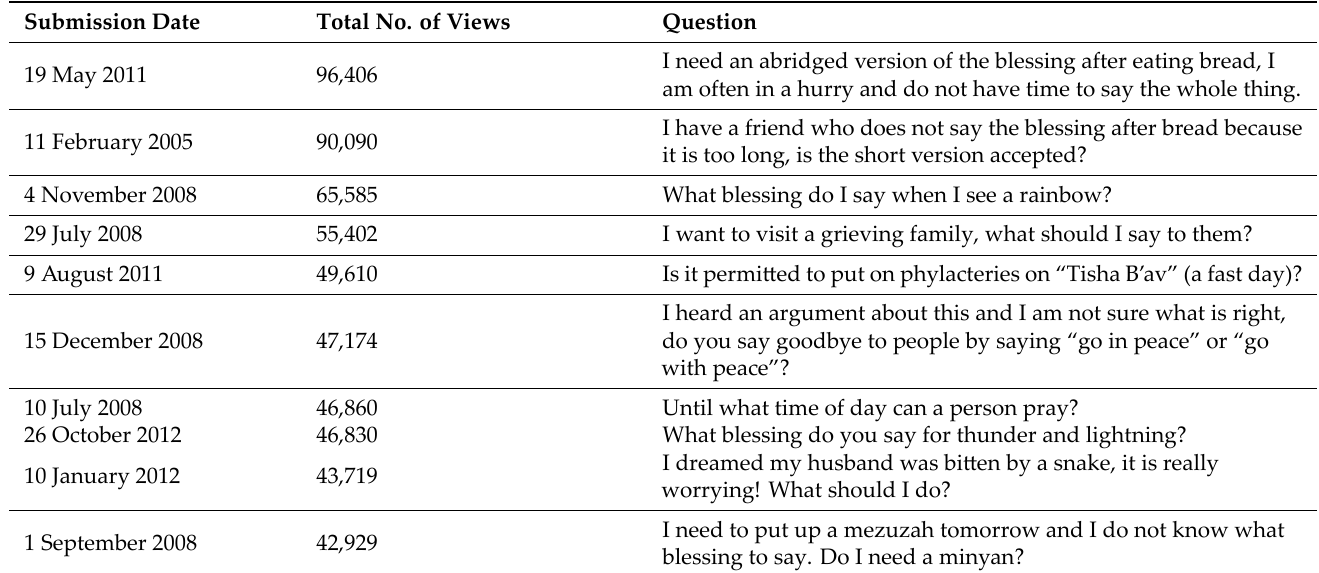
Table 2. Most popular questions by total view count between 2005 and